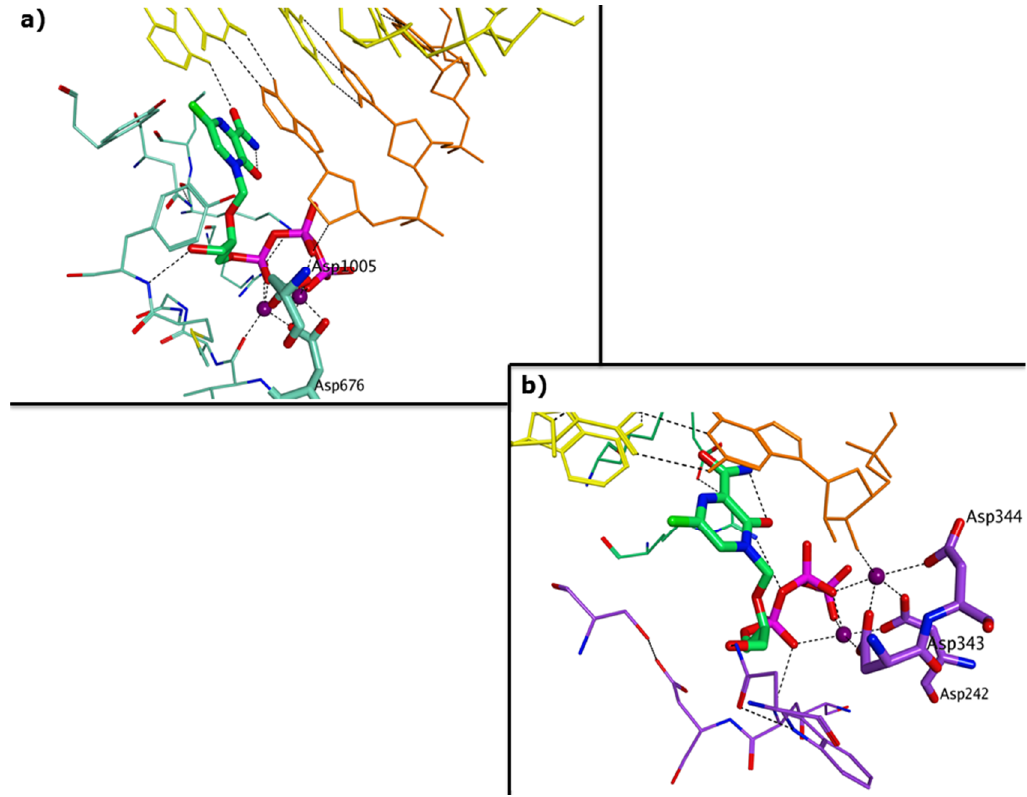
Figure 9. Predicted binding of one suggested potential broad-spectrum polymerase inhibitor to the HAdV Pol model ( a ) and to HNoV NTP binding pocket in the 3BSN crystal structure ( b ).